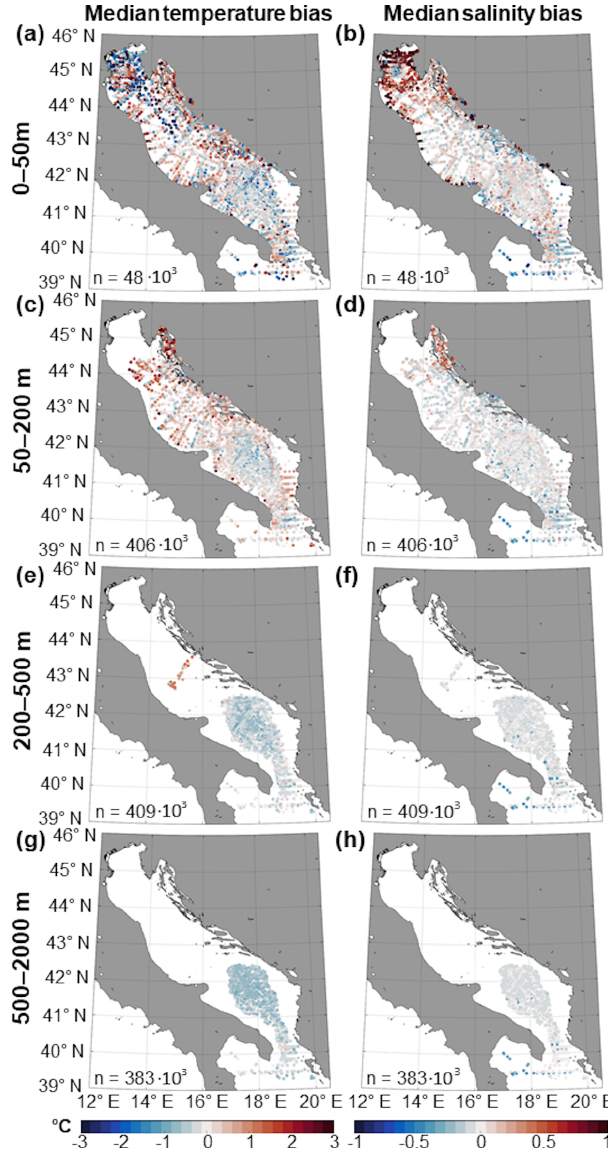
Figure 7. Median of the temperature (left panels) and salinity (right panels) biases between AdriSC ROMS 1km model results and CTD observations for depth ranges (a, b) 0–50m, (c, d) 50–200m, (e, f) 200–500m, and (g, h) 500–2000m, with the total number of points n (bottom left